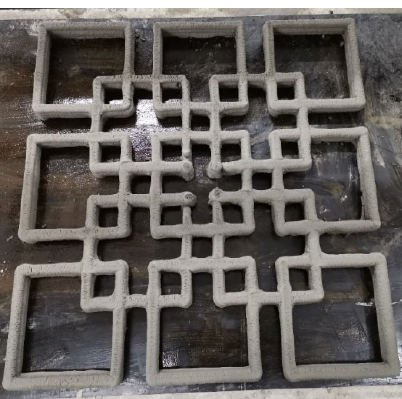
Figure 9. Concrete component printed by the method in this paper.